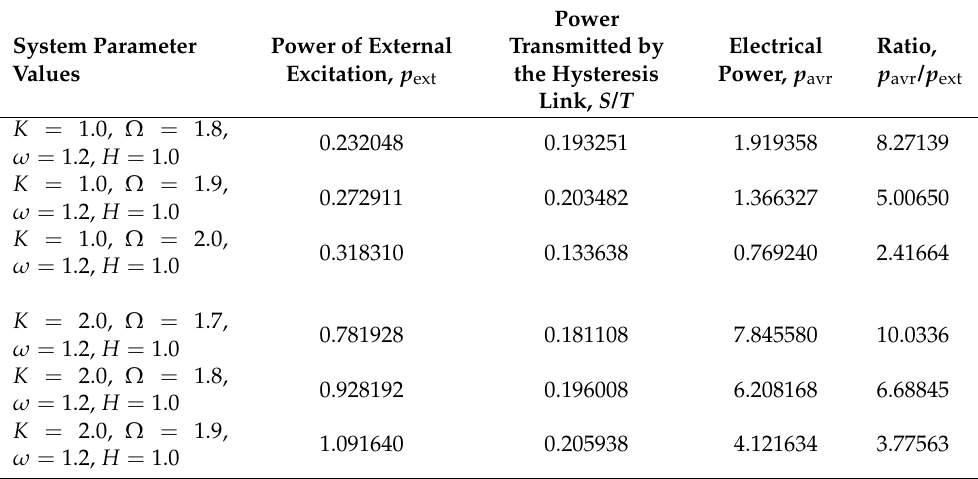
Table 1. Power of external excitation and transmitted power in the case of a hysteresis link within the Preisach model.